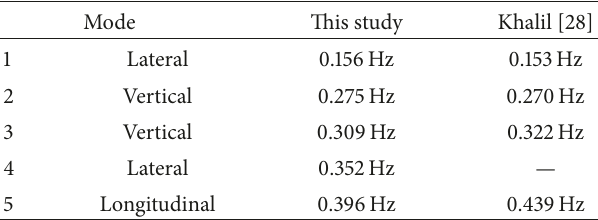
Table 8: Natural frequencies of the Skytrain Bridge.